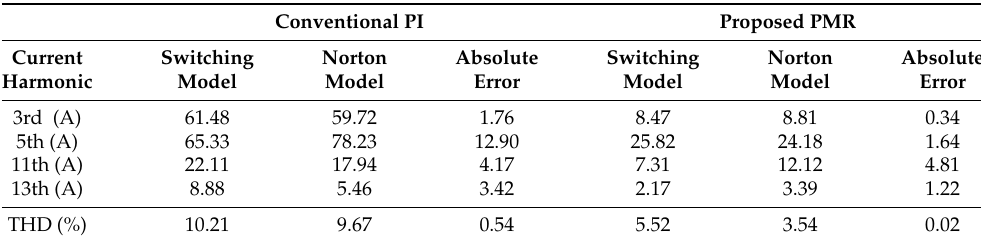
Table 4. Current harmonic injection levels at PCC of derived models for 3L-TNPC Circuit 1 by using PI and proposed PMR